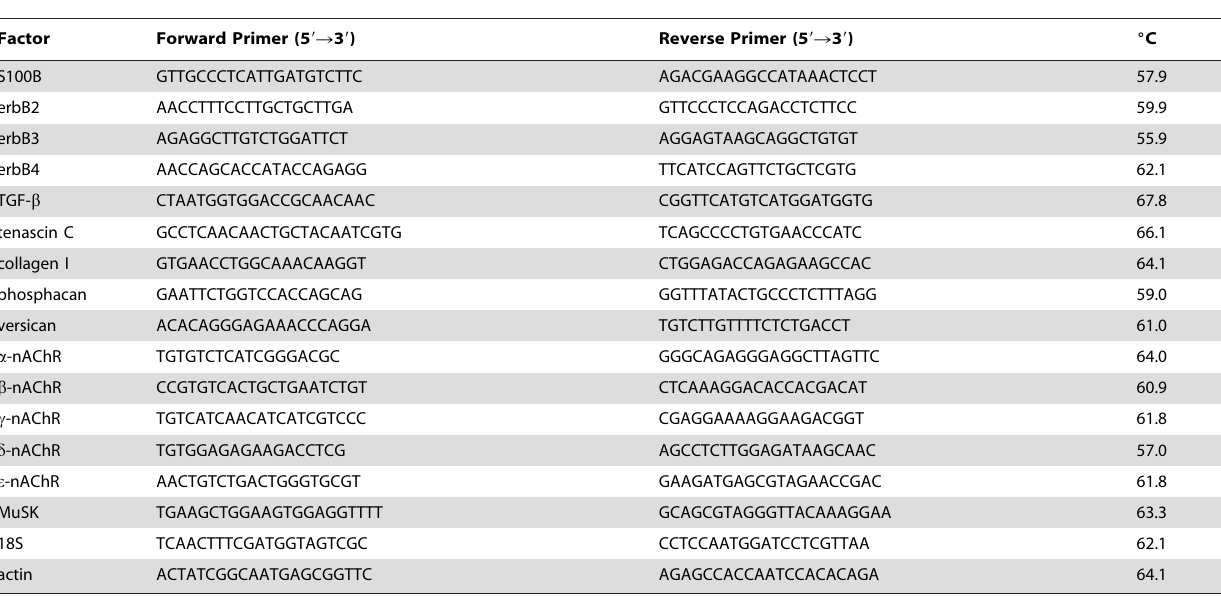
Table 1. Primer sequences for RT-PCR and annealing temperatures (˚C).